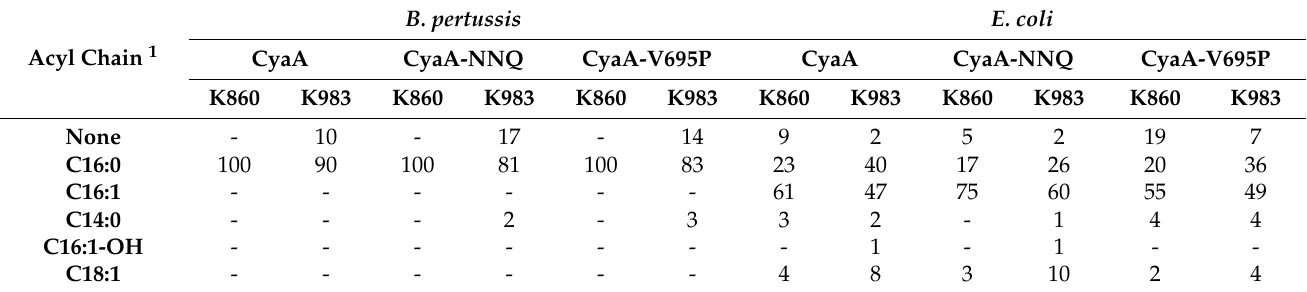
Table 1. Acylation status of the CyaA variants purified from B. pertussis and E. coli . B. pertussis Acyl Chain 1